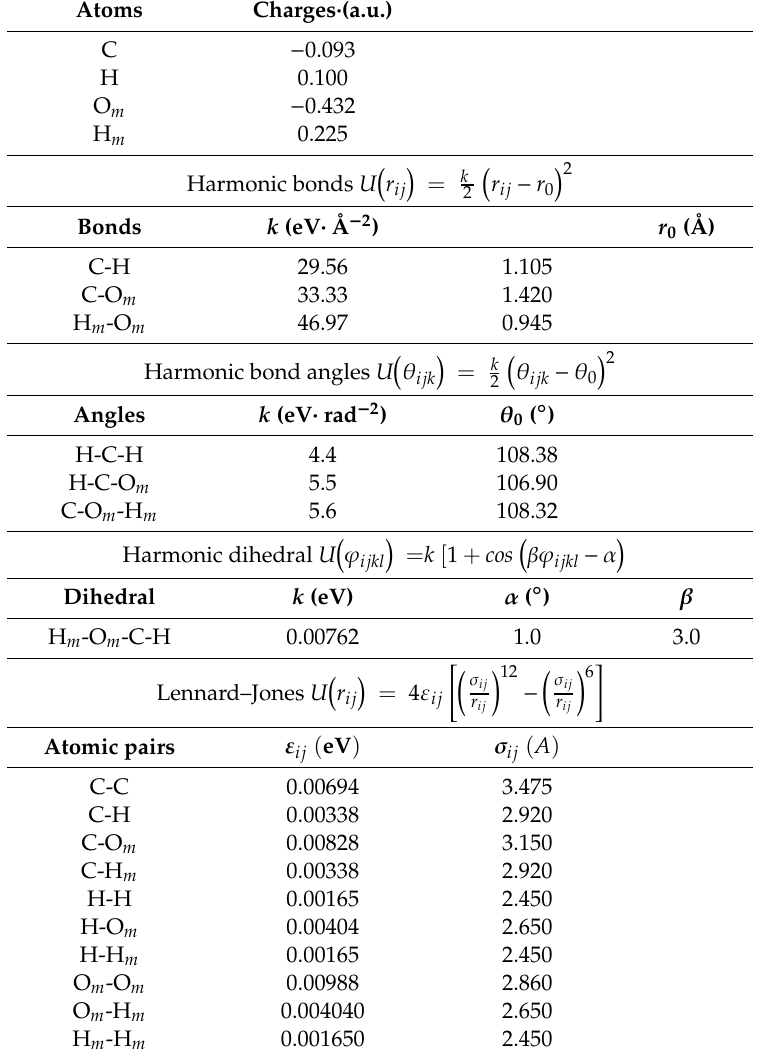
Table 3. Potential parameters describing the intra- and inter-molecular interactions for methanol a . Atoms Charges ·